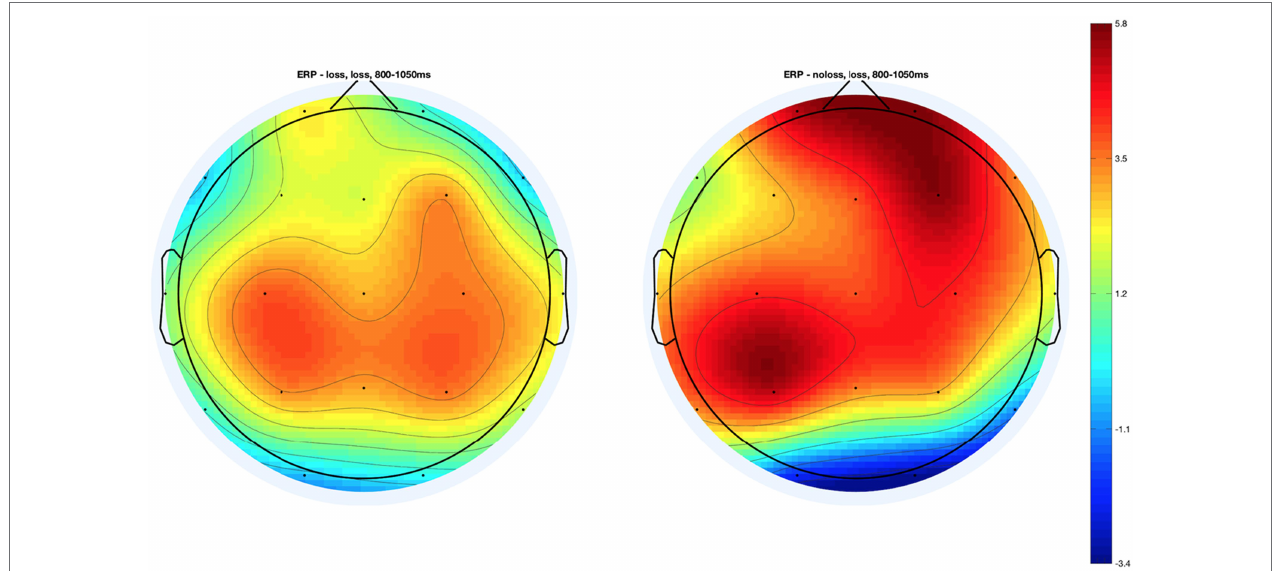
FIGURE 5 | Topography maps of the very late Late Positive Potential (VLLPP) in the Psychological-pain condition in two